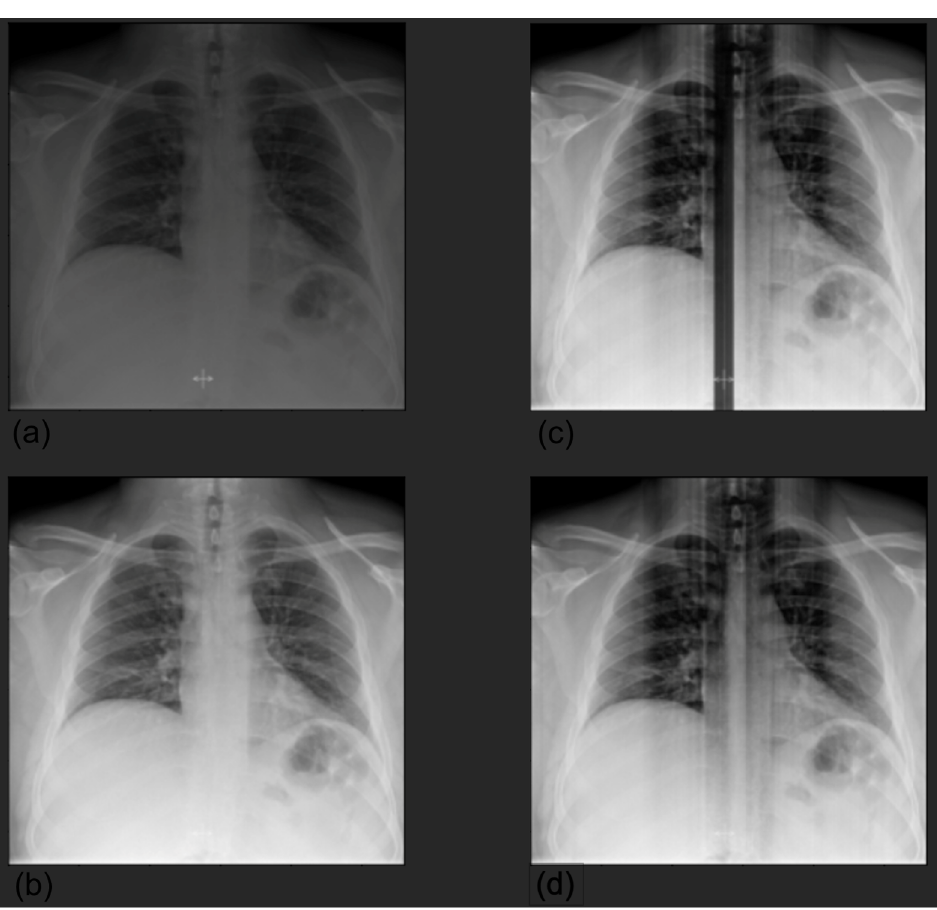
Figure 1. Preprocessing by clipping values larger than the 0.9995 quantile. The presence of a landmark, significantly whiter than the other pixels, created significant noise after normalization ( a ); original image ( b ); clipped image ( c ); normalized original image ( d ). To match the input dimension of the models, we resized the images to 224 × 224 and encoded them as RGB images by repeating the images for three channels. This was a necessary step in order to use the state-of-the-art image classification networks already pretrained on the ImageNet dataset. Then, we normalized each image by scaling the values in the range.